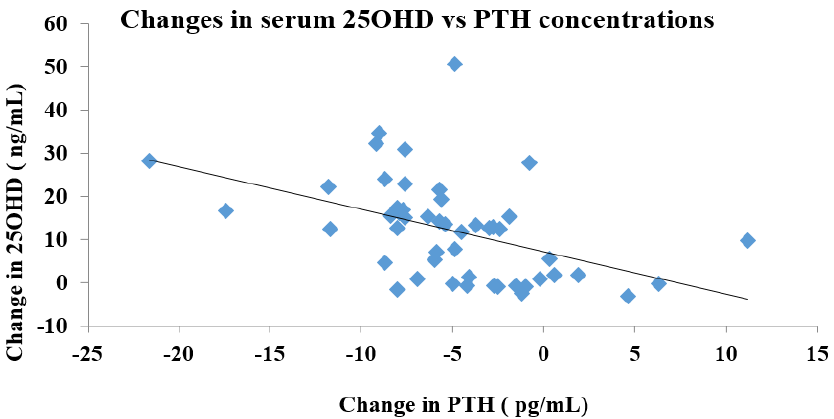
Figure 8. Correlation analysis of changes in 25OHD concentrations vs. changes in PTH concentrations. Pearson’s correlation coefficient is reported as r value.